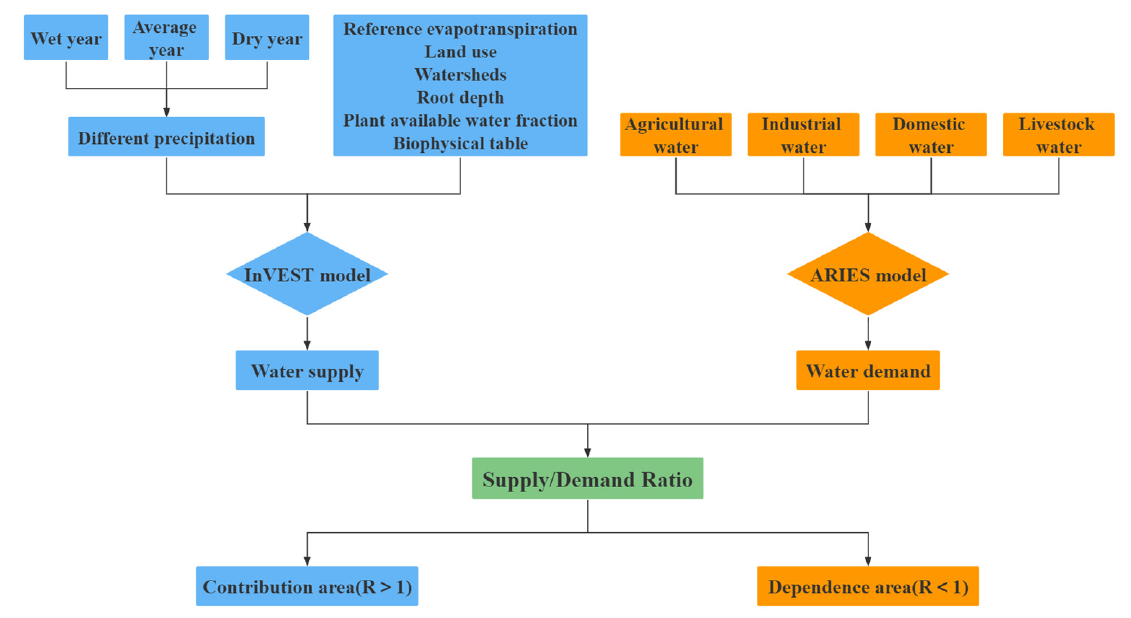
Figure 2. Supply-and-demand relationship of water resources in western Jilin.